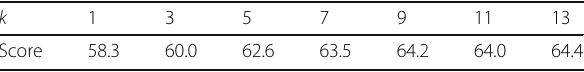
Table 2 Scores of different k -sized GICNs on the test set